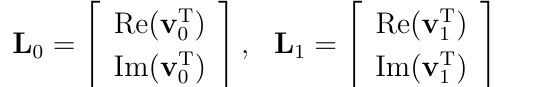
(dots for D and diamonds for D ) are plotted for single realizations of complex Gaussian reporting 0 1 channels, which correspond to Rayleigh fading channels. In this plot, we have adopted M = 3 , K = 2 , ..., h ] T = [ − 0 . 9598 − j 0 . 3668 , − 0 . 2029 + j 1 . 0683 , 0 . 6646 − j 0 . 6109] T . Also plotted in and h = [ h 1 M Figure 6 are the decision regions defined from the true ML rule Inequality (2) (shaded with vertical lines for H ) and the approximate ML rule Inequality (7) (shaded with horizontal lines for H 1 /N ≈ 0 dB, a value for which the difference in using Inequalities (2) or regions were plotted for E 0 b